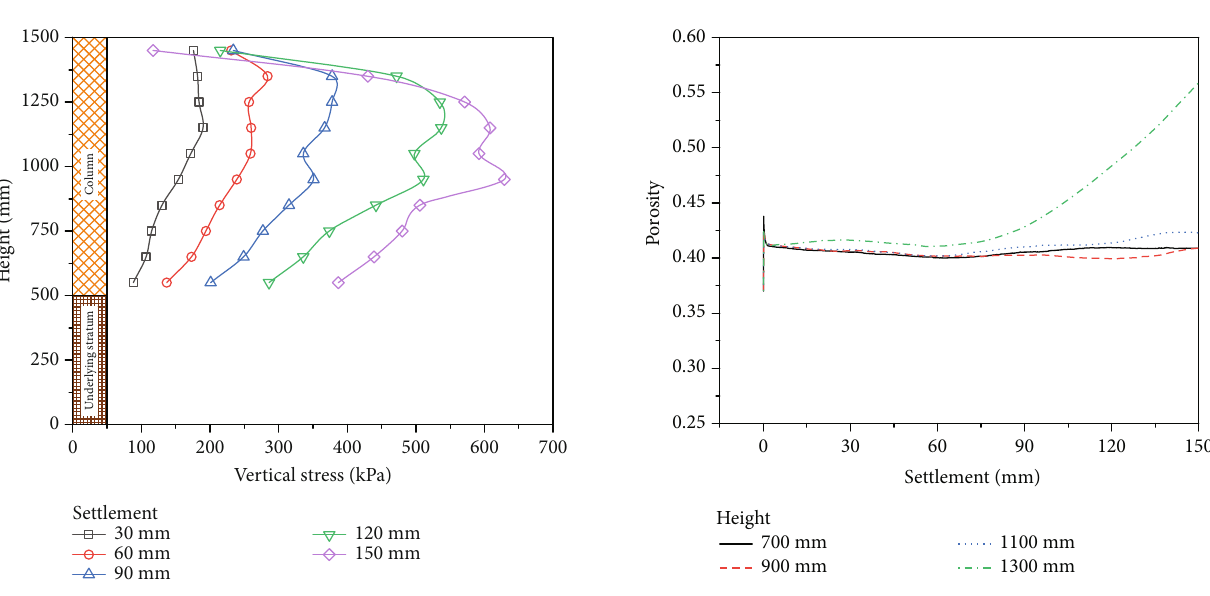
Figure 6: Porosity changes of the column during loading.